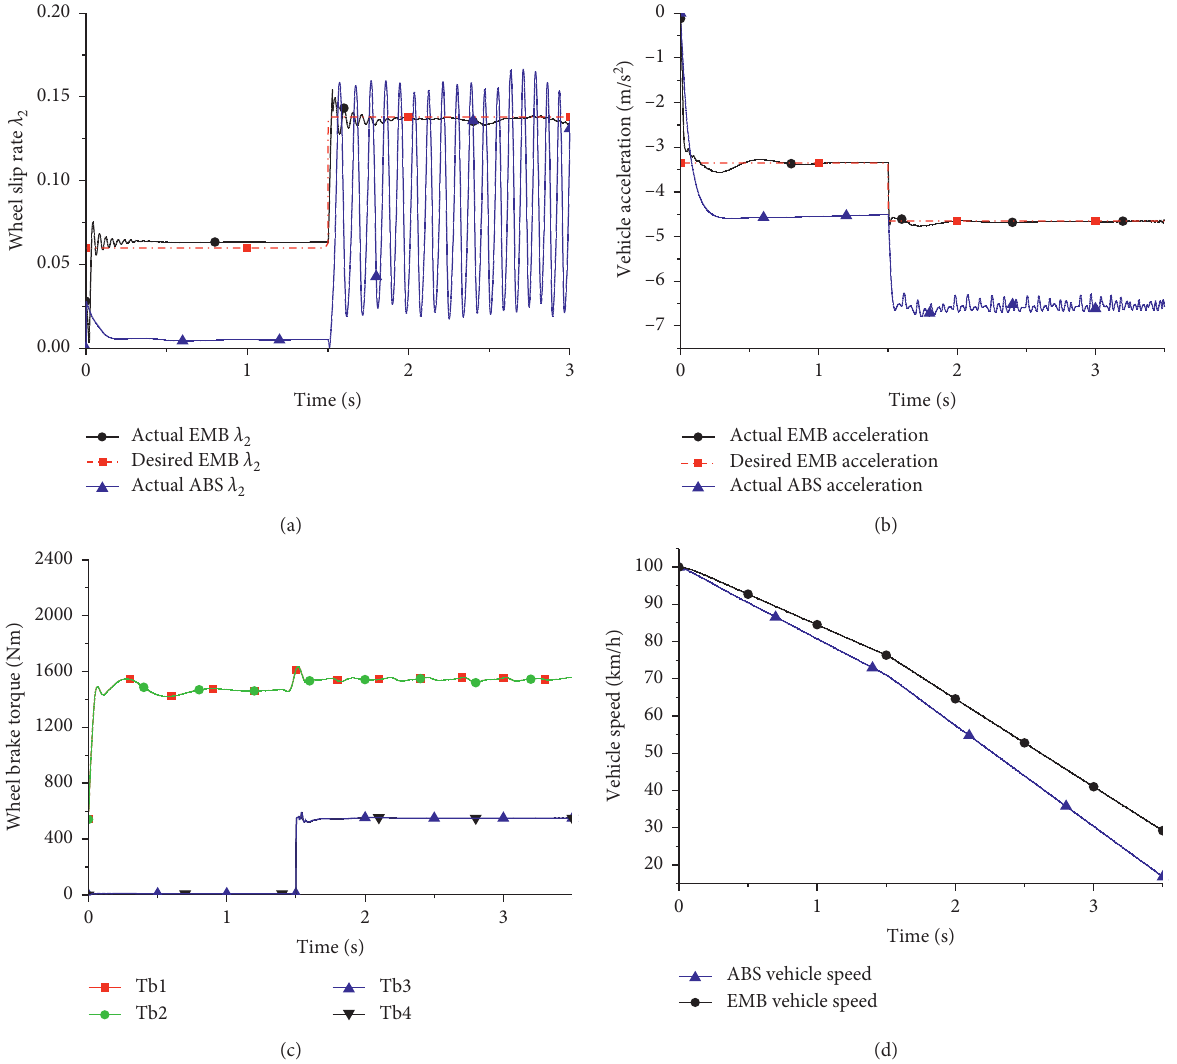
Figure 13: Wet asphalt pavement, switch medium comfort brake to emergency brake. (a) Wheel slip rate. (b) Vehicle acceleration. (c) Wheel brake torque. (d) Vehicle